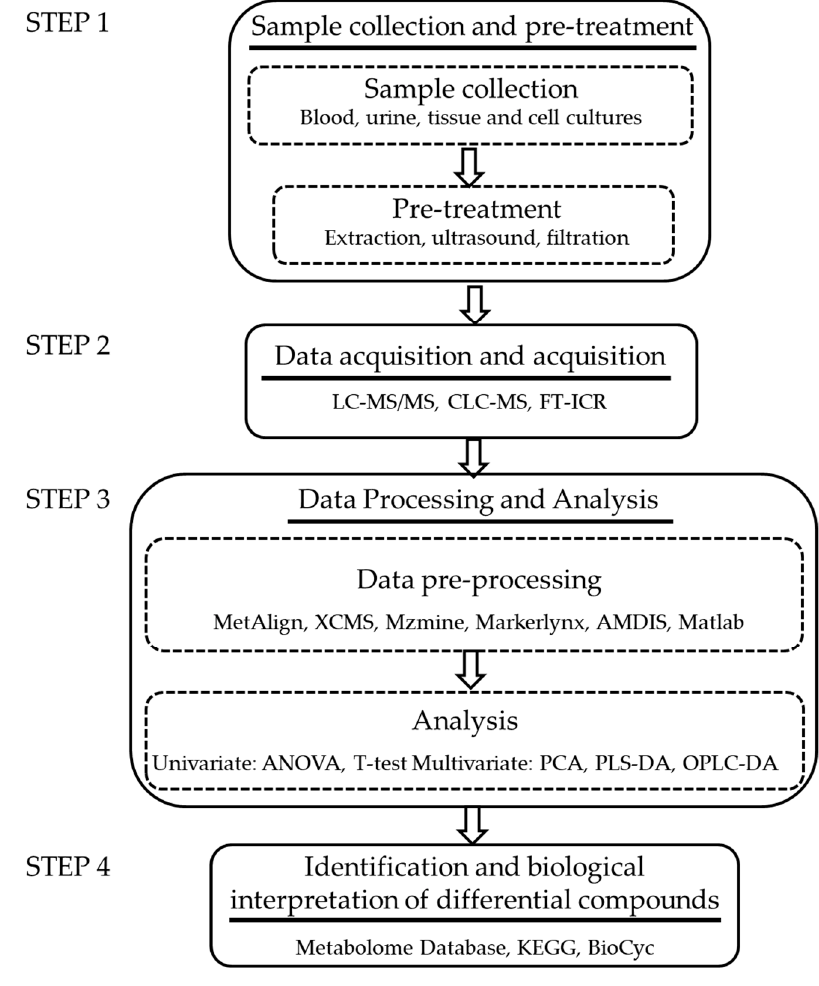
Figure 1. The workflow of discovering differential compounds by the LC-MS-based metabolomic